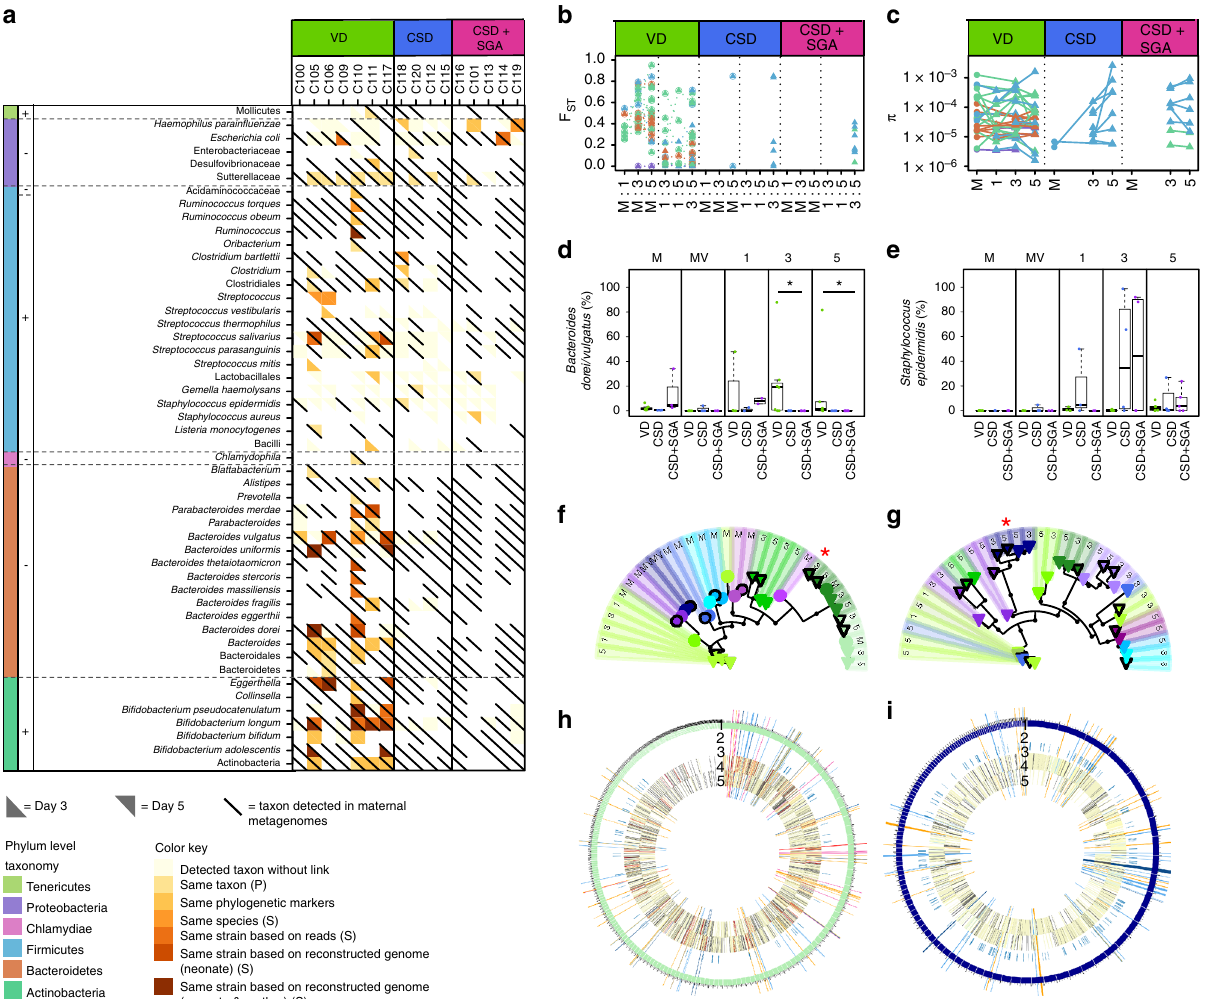
Fig. 3 Transmission of functions by distinct microbial strains. a Taxa which were detected in gut microbiomes of mothers (diagonal line) and neonates (on postnatal day 3 (below the line) and/or day 5 (above the line), indicated by shading) in vaginal delivery (VD), caesarean section delivery (CSD) and CSD with small for gestational age (SGA) status (CSD + SGA) groups. The level of evidence of transmission is indicated by the shading colour, with darker shading for stronger evidence. A taxon without link describes a taxon that was found in the maternal samples, but not shared between mother and neonate. P based on PhyloPhlAn; S based on StrainPhlAn. Neonates C115 and C116 are twins. b Inter-population fi xation indices (F ST ) comparing maternal (M) and neonatal (days 1, 3, 5) faecal samples. Phylum-level colour key is given in a . Encircled symbols highlight strains that are shared with the respective mother. c Intra-population diversity index ( π ). Circles and triangles represent maternal and neonatal faecal samples, respectively. d , e Relative abundance of the metagenomic operational taxonomic units (mOTU) belonging to Bacteroides dorei/vulgatus ( d ) and Staphylococcus epidermidis ( e ) in maternal faecal (M), maternal vaginal (MV) and neonatal faecal (days 1, 3, 5) samples from VD, CSD and CSD + SGA groups; *false discovery rate (FDR)-adjusted P < 0.05 in Wilcoxon rank-sum test for two-group comparisons; boxplots: centre line – median, bounds – fi rst and third quartile, whiskers < = 1.5 x interquartile range. f , g Strain-level phylogenetic trees of B. vulgatus ( f ) and S. epidermidis ( g ); black bordered and borderless symbols represent genome reconstructions and read-based strain-level identity, respectively; genome reconstructions marked with a red asterisk are represented in h and i . h , i Genome reconstructions of B. vulgatus from neonatal faeces (C117; VD; day 3; bin P2.2.1) ( h ) and S. epidermidis from neonatal faeces (C112; CSD; day 5; bin P2.2) ( i ). Circular tracks represent: assembled contigs (1), single-nucleotide variants (black), shared between mother and neonate (red) (2), positions of strain markers (3), abundance fold-changes between VD and CSD (±SGA) neonates for functionally annotated genes in forward (4) and reverse directions (5); long spokes highlight genes af fi liated with enriched pathways as depicted and colour-coded in Fig. Immunostimulatory potential of the earliest gut microbiome . As LPS forms part of the outer membrane of Gram-negative